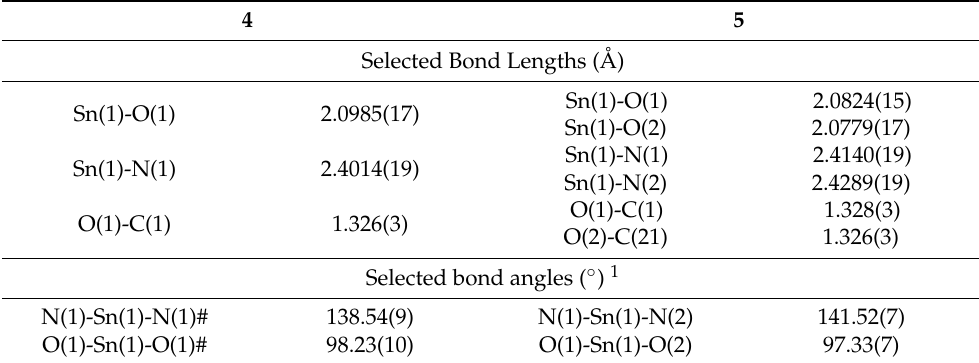
Figure 7. The molecular structure of 4 ( a , c ) and 5 ( b , d ). Thermal ellipsoids are shown at 50% probability. H-atoms are omitted for clarity. Solvent of crystallization (toluene) in 5 is omitted for clarity. Symmetry transformations used to generate equivale nt atoms: #1 3/2−X, Y, 1−Z. Table 4. Selected bond lengths (Å) and bond angles ( ◦ ) for complexes 4 and 5